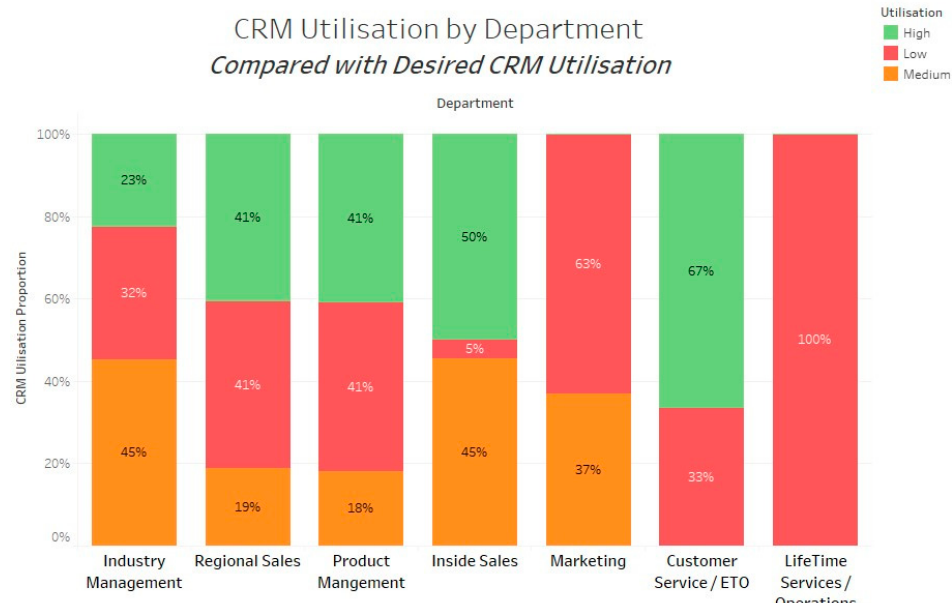
Figure 2. Level of CRM actual utilisation against desired utilisation by function and department— developed for this study.